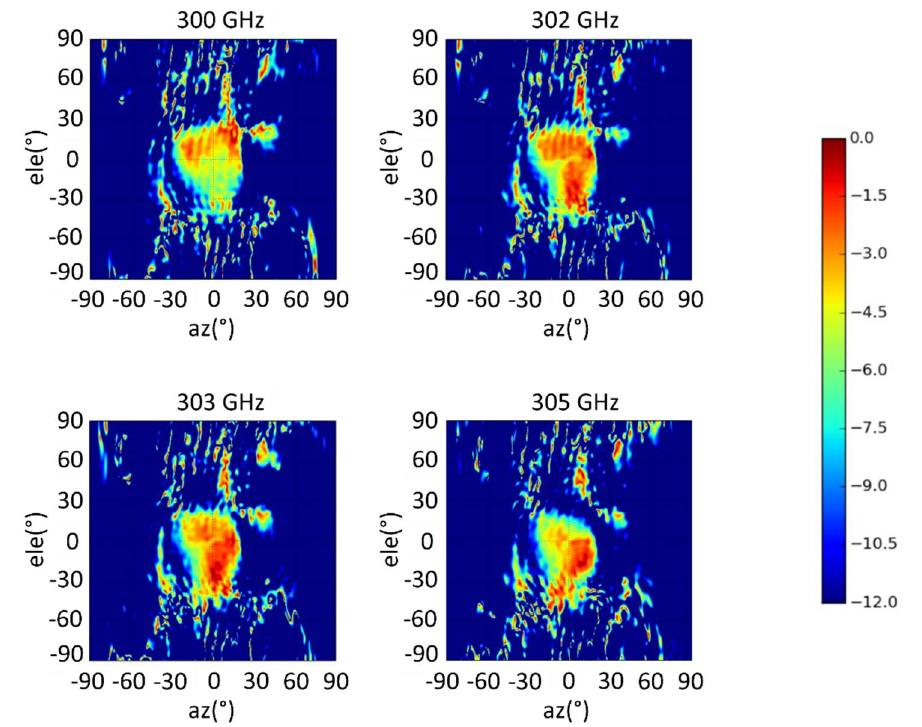
Figure 7. Measured 2D AR of the proposed antenna at different frequencies.